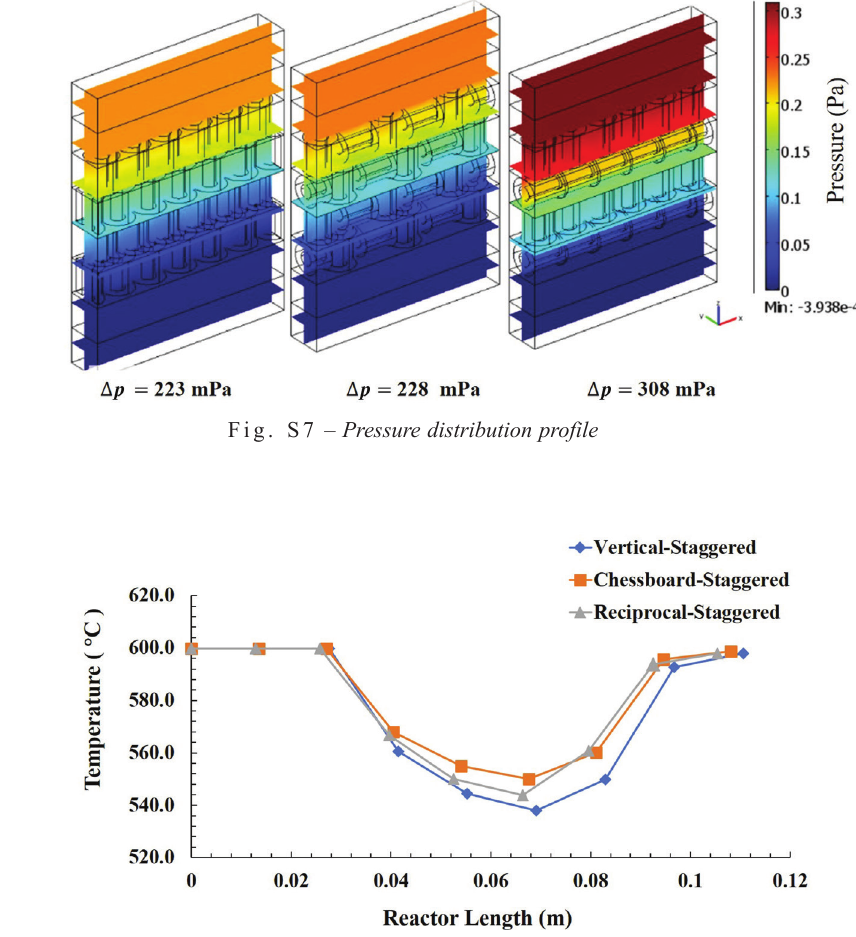
Fig. S8 – Temperature gradient in different Raschig ring positions during DMR